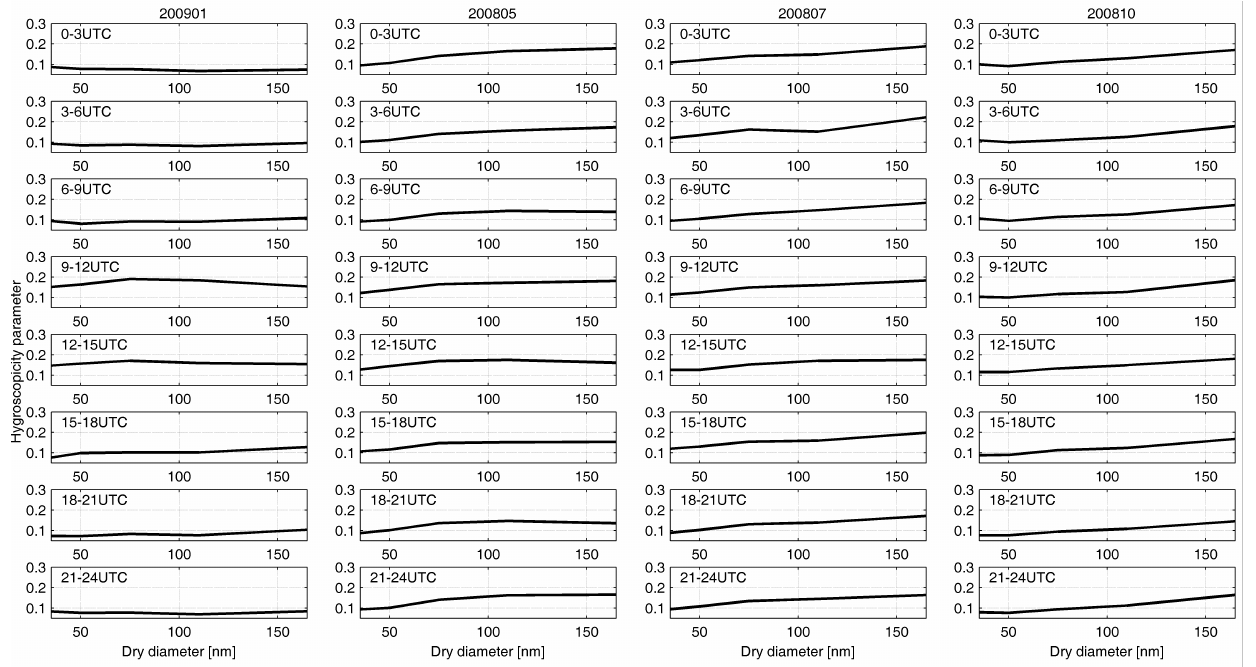
Fig. 3. Hygroscopicity parameter versus dry diameter for January 2009, May 2008, July 2008 and October 2008.